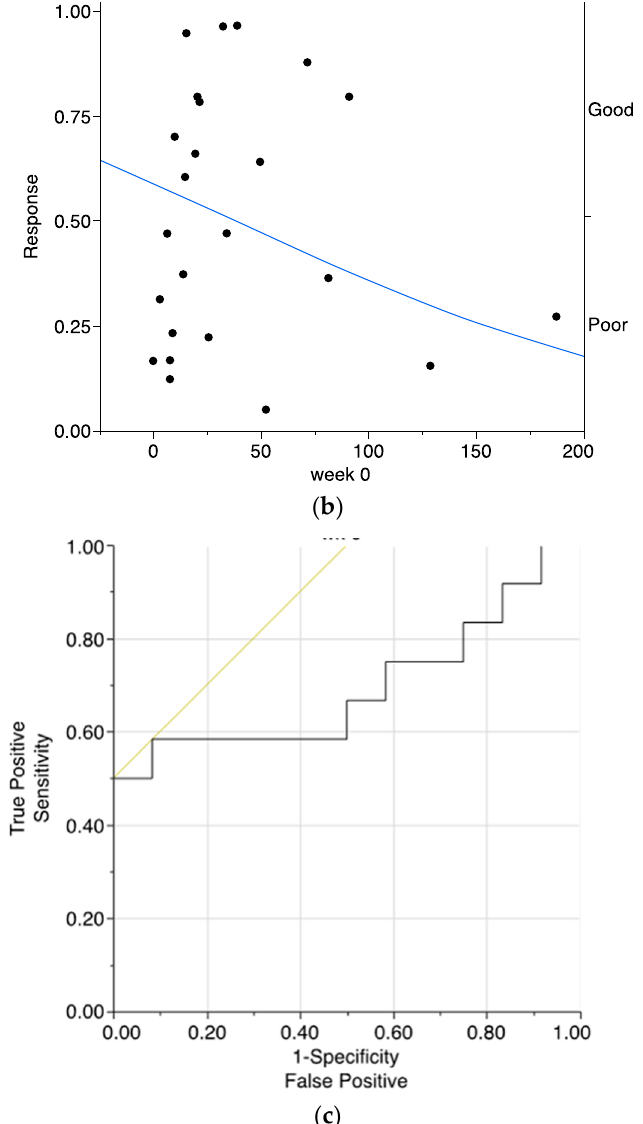
Figure 5. ( a ) Patients were divided into two groups based on whether or not the urinary albumin/creatinine ratio decreased less than 50%. The good responder group was defined as % change in urinary albumin/creatinine ratio < − 50%; ( b ) Logistic analysis was conducted by the urinary angiotensinogen/creatinine ratio before the treatments. The receiver operating characteristic (ROC) curve was plotted. The vertical axis shows whether the urinary albumin/creatinine ratio decreased less than 50%; ( c ) Area under the curve (AUC): 0.694; cutoff value of urinary angiotensinogen/creatinine ratio: 13.9 µg/g Cr; maximum Youden index: 0.500 (( b , c ) specificity: 11/12 = 91.7% and sensitivity: 07/12 = 58.3%).